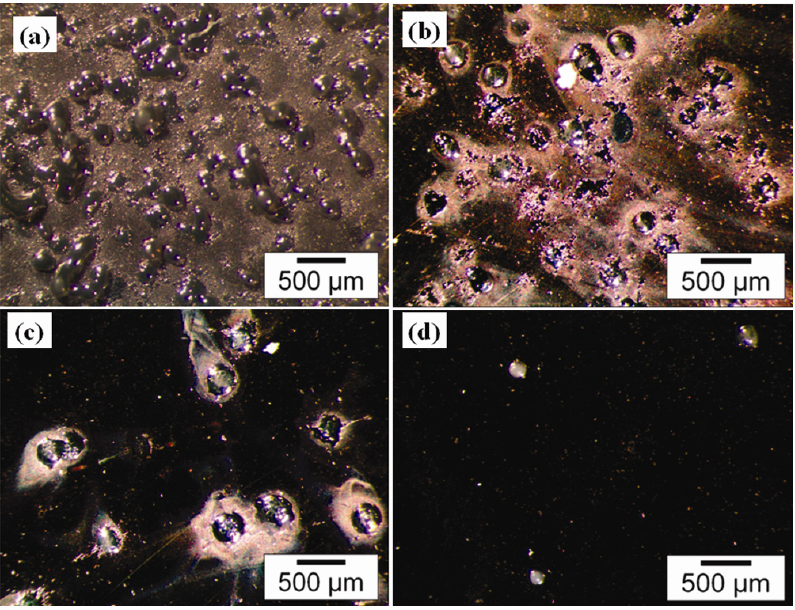
Figure 9. SOD effect on microstructure of splat and splash splat on mild steel